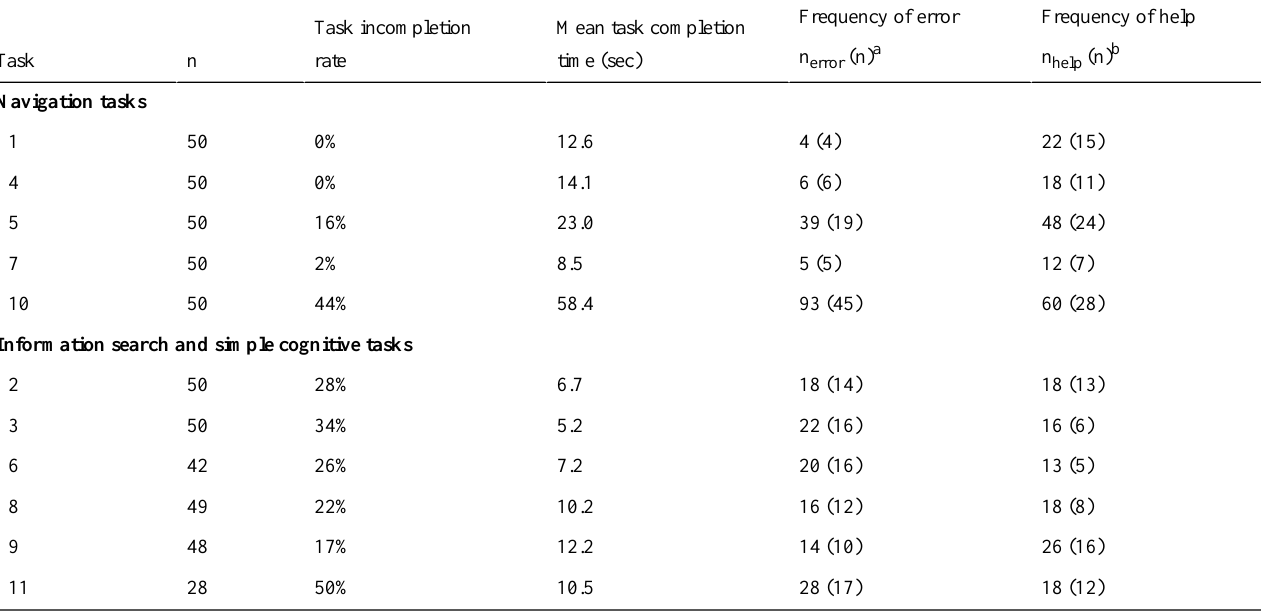
Table 6. Performance measures as assessed via 11